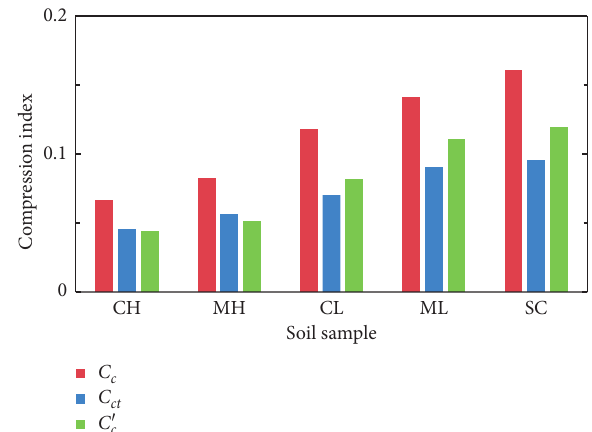
Figure 10: Conventional compression indexes of the unsaturated MH soil with different dry densities.